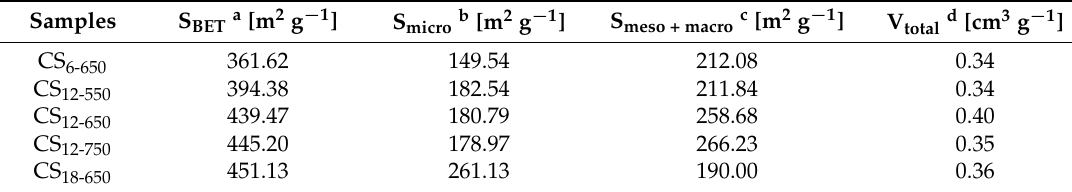
Table 1. Surface area, porosity of CSs.